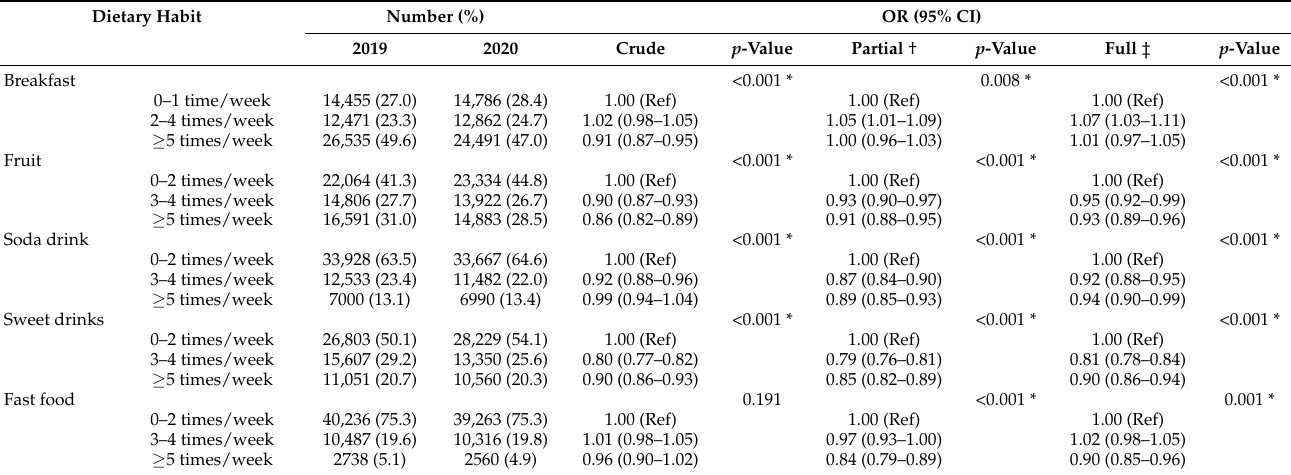
Table 2. Odd ratios of dietary habits in 2020 compared to 2019 in total participants.